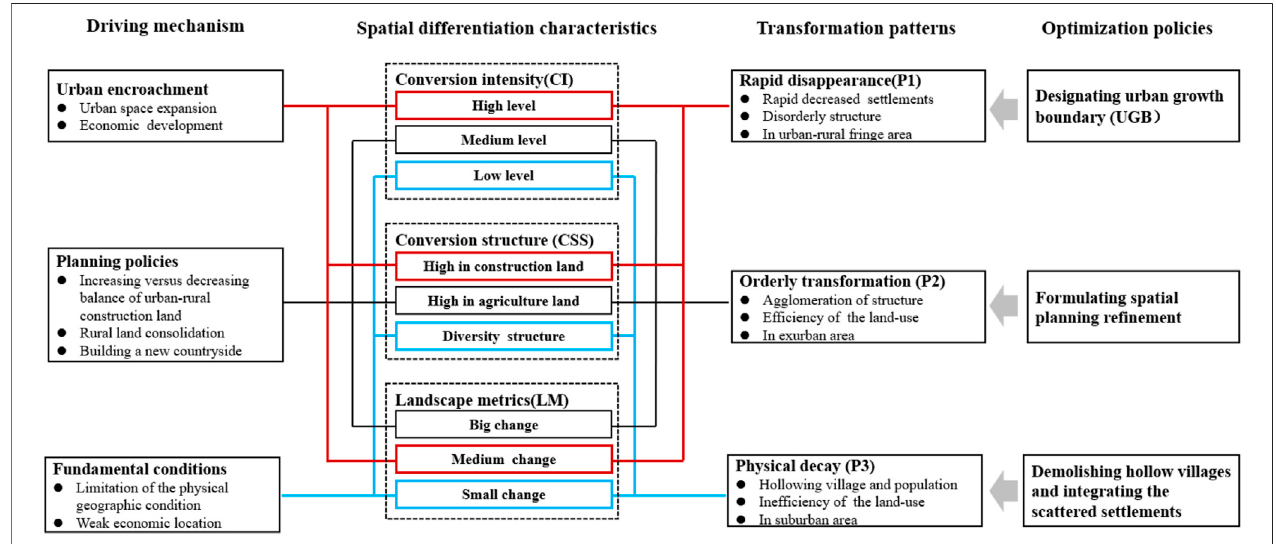
FIGURE 8 | The space differentiation characteristics, driving mechanism, and optimization policies of rural settlements transformation